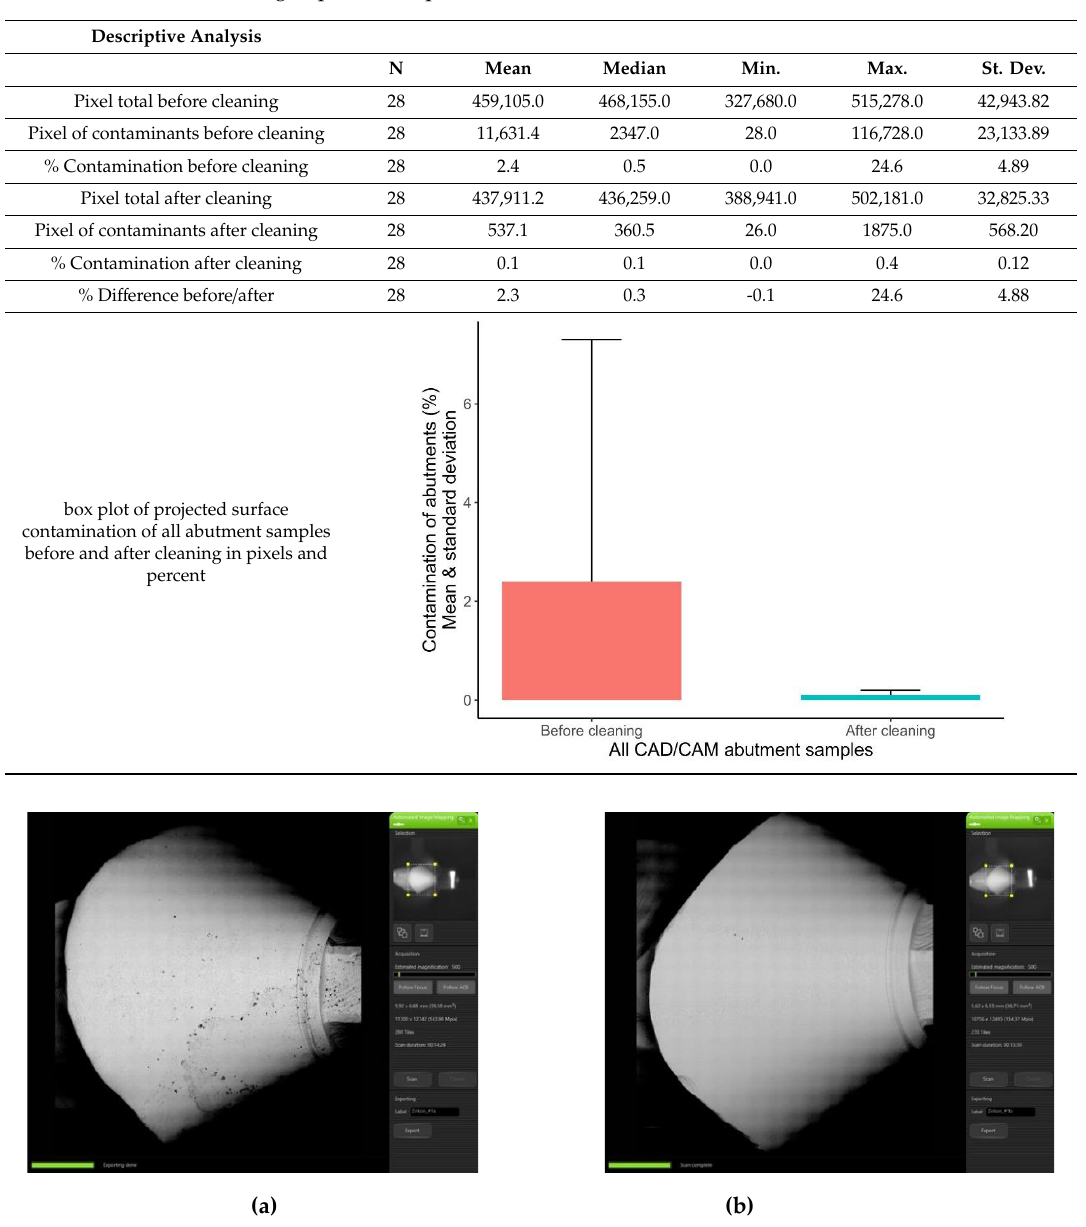
Figure 5. Representative examples of SEM images (500×) of zirconia monotype abutment #1a before ( a ) and after cleaning ( b ), showing the effective reduction of projected surface contamination.